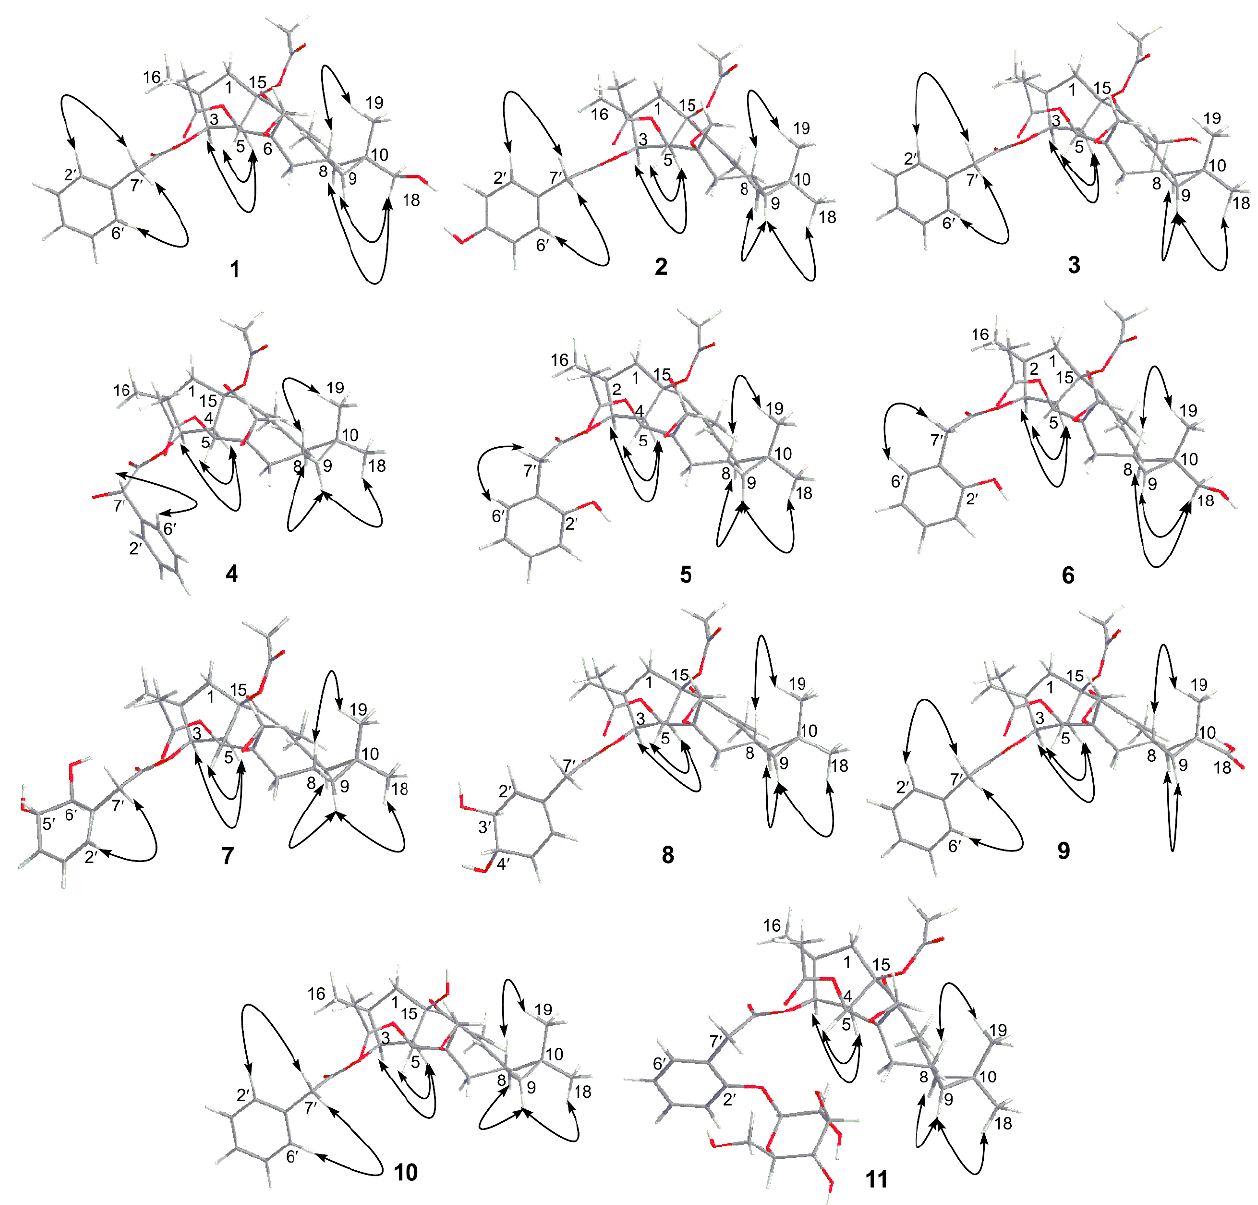
Figure 7. NOESY ( ↔ ) correlations of compounds 1–9 and 11–12 . Compound 5 was isolated as a white powder with the optical rotation [ α ] 20 ( c 0.108, MeOH). The molecular formula was inferred as C 32 H 40 O 9 due to the appearance of an [M + H] + ion at m / z 569.2754 in the HR-ESI-MS spectrum. In the 1 H and 13 C NMR spectra of 5 (Tables 1 and 3), compared to euphorbiasteroid, it was observed to have one additional oxygenated quaternary carbon at δ C 154.7, replacing an aromatic methine of the benzyl ring. Additionally, the 1 H NMR spectrum exhibited four aromatic proton signals for an AA (cid:48) BB (cid:48) coupling system at δ H 6.90, 7.18, 6.88, and 7.11. The above information,